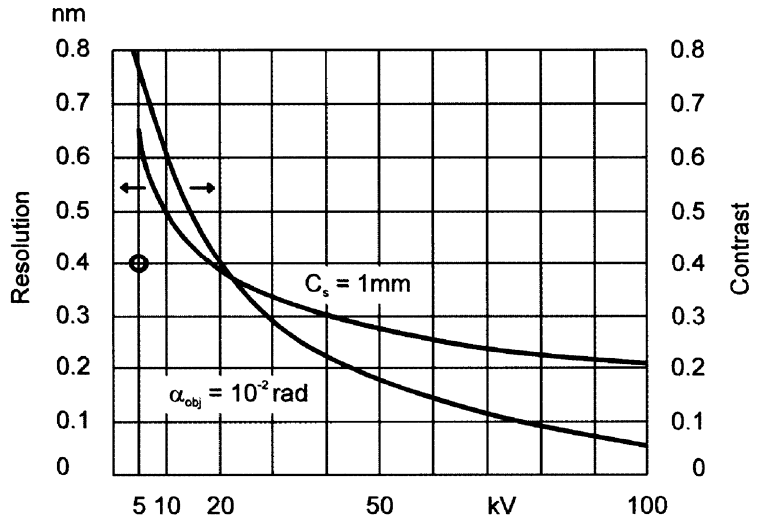
Figure 1. The dependence of contrast and resolution on the accelerating voltage of the primary electron beam for TEM imaging of 20 nm carbon layers [20,27].